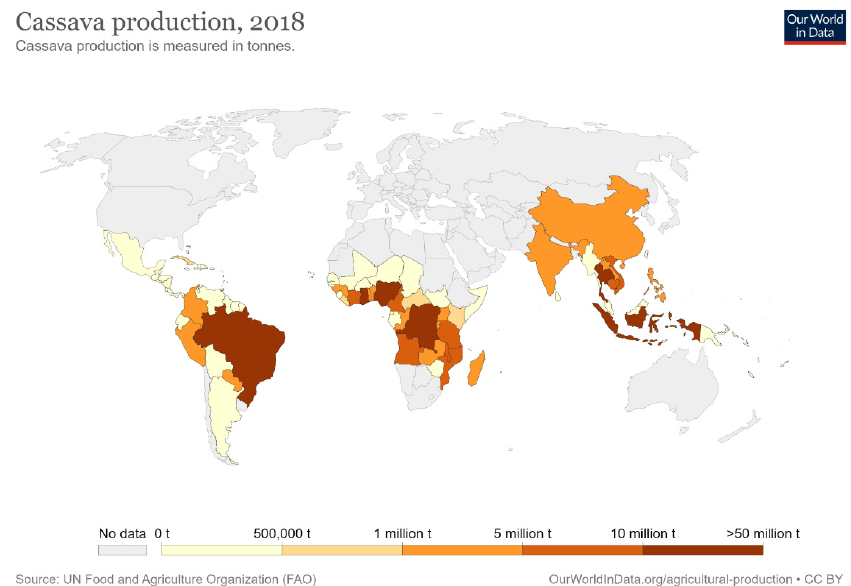
Figure 2. Cassava production statistics by country in 2018